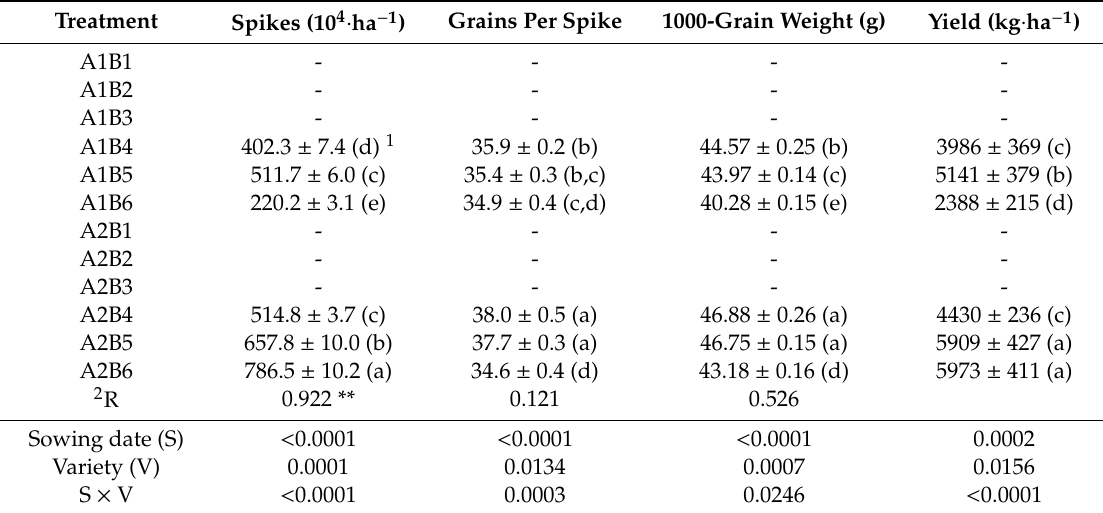
Table 10. Wheat yield and yield component for di ff erent sowing dates (2014–2015).